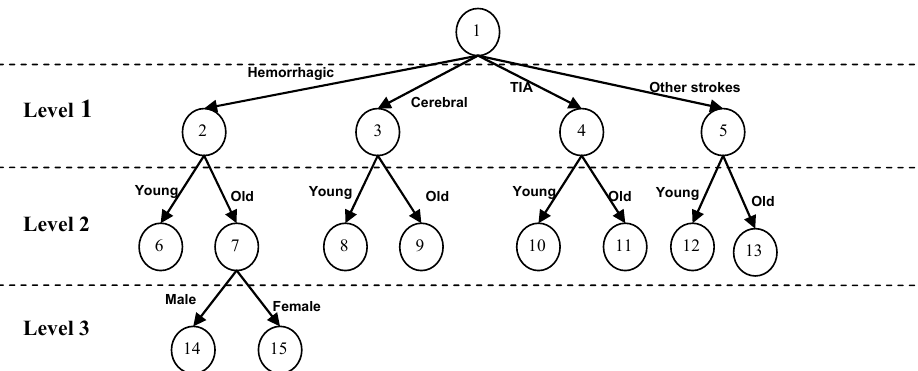
Figure 2. The schematic representation of the phase-type survival tree constructed using the WIC- based splitting criteria.